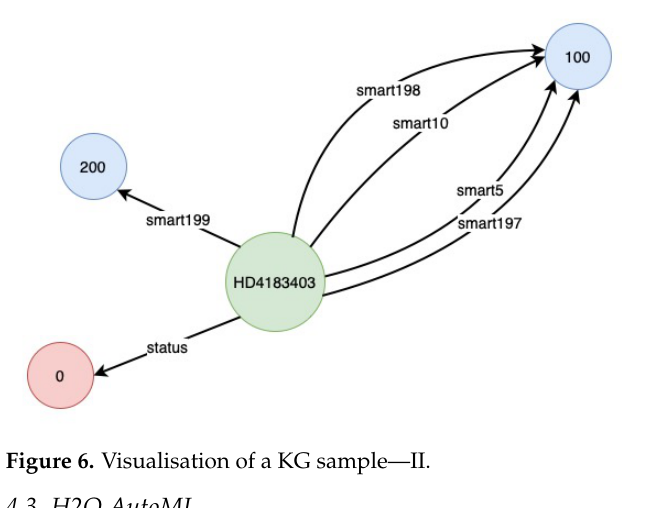
Figure 6. Visualisation of a KG